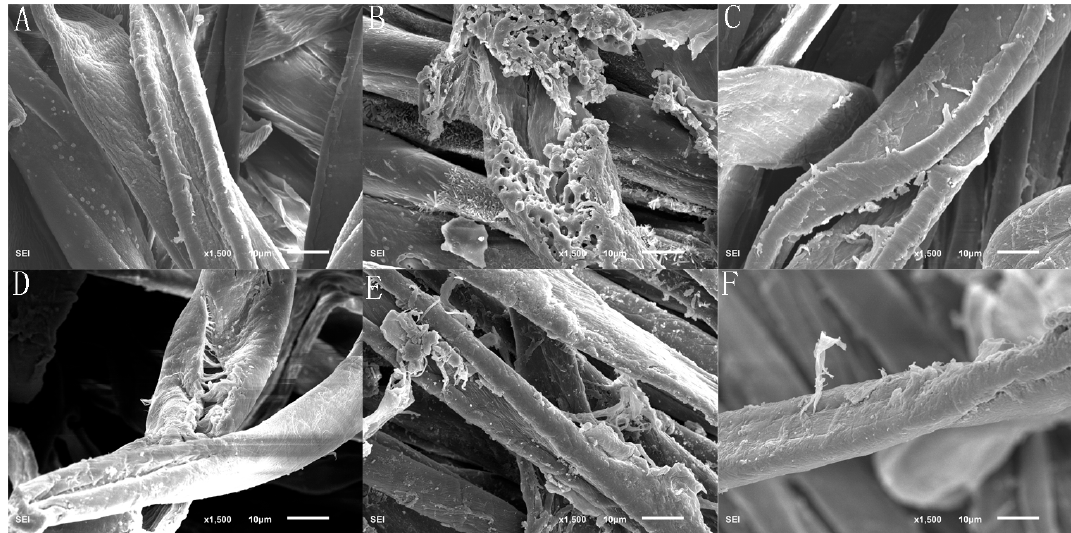
Figure 5. SEM pictures of different treatment of cotton denim fabrics (×1500): a Desized, b laser bleaching, c enzyme bleaching, d NaClO bleaching, e KMnO 4 bleaching, f H 2 O 2 bleaching.